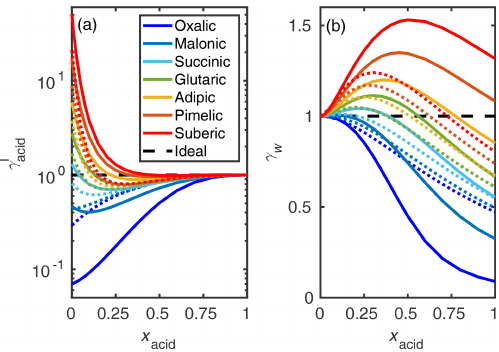
Figure 6. COSMO-RS- (solid lines) and UNIFAC-estimated (dot- ted lines; AIOMFAC-web, 2020) activity coefficients ( γ I ) of (a) di- carboxylic acids and (b) water in the binary acid–water mixtures at 298.15K. All COSMO therm -estimated activity coefficient values are given in Tables S5 and S6 of the Supplement.